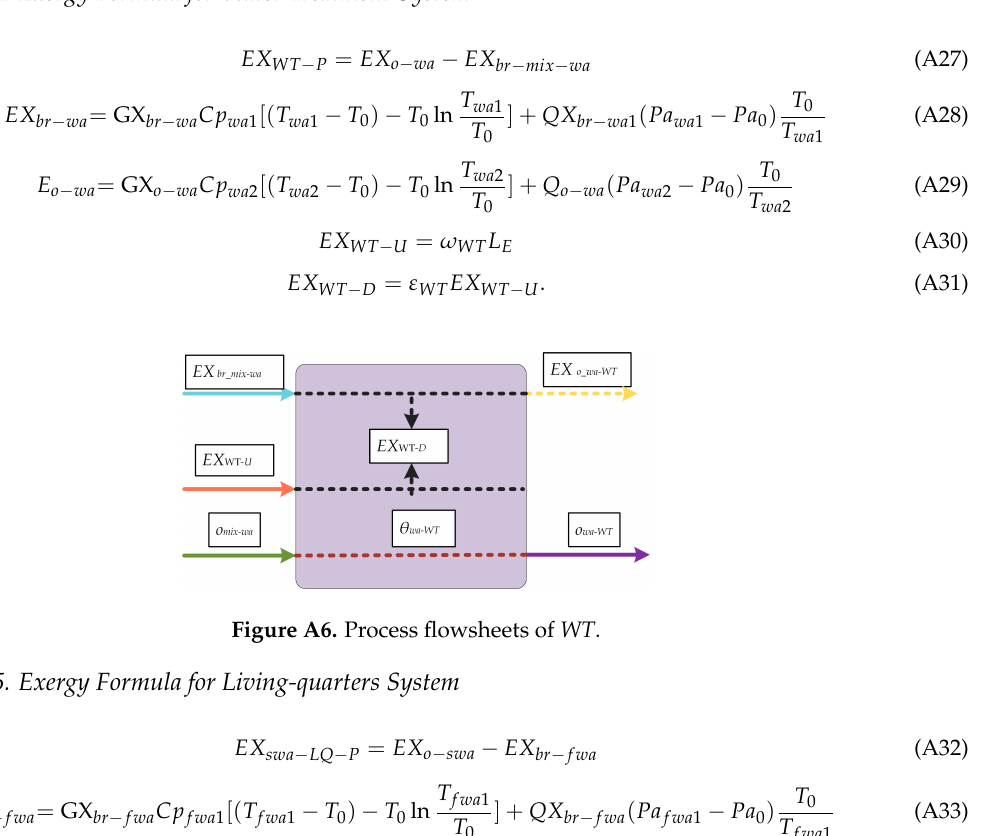
Figure A5. Process flowsheets of NG-co .